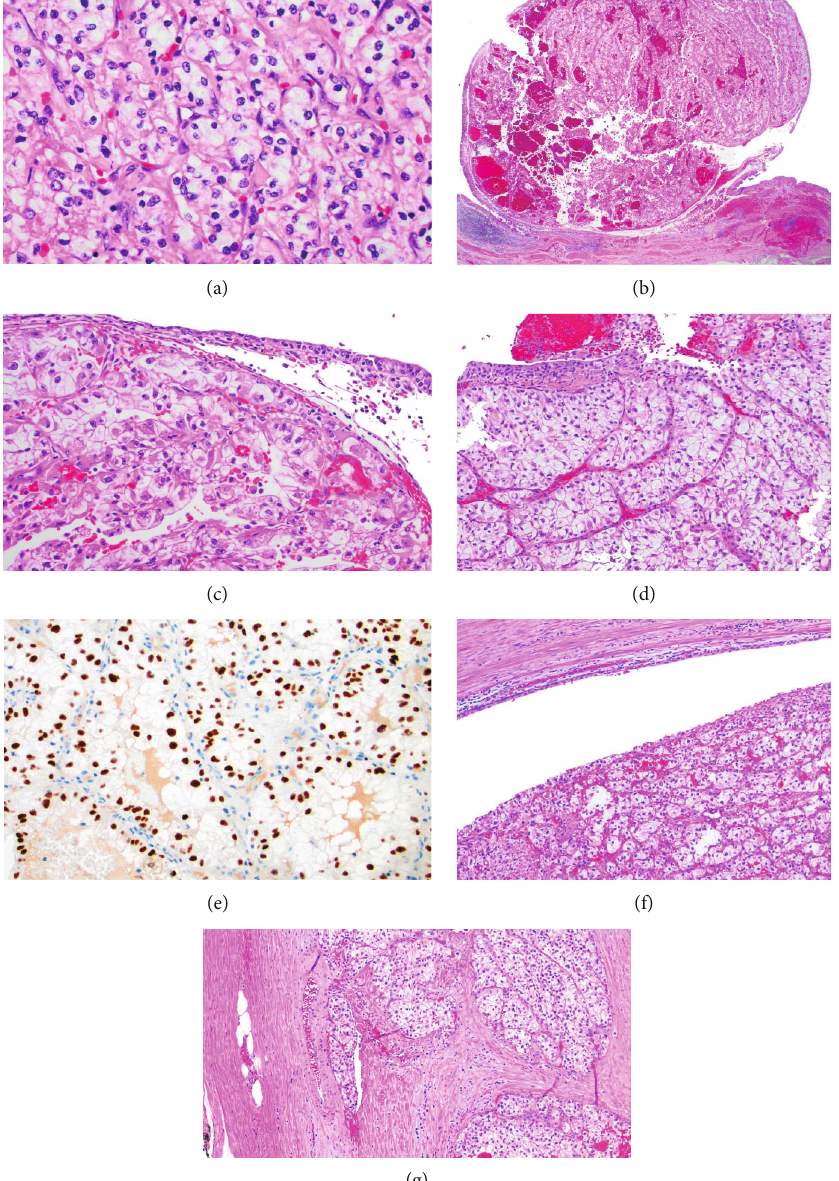
Figure 2: H&E-stained sections from the radical nephrectomy showed (a) areas of classic low-grade clear cell renal cell carcinoma (40x) and (b) an exophytic nodule of tumor undermining ureteral epithelium (2x). (c) Higher magni fi cation of tumor invading the ureteral wall shows higher grade nuclei and tumor cells with voluminous and focally eosinophilic cytoplasm undermining urothelium (20x). (d) Transurethral resection of the subsequent bladder tumor showed tumor morphologically identical to that seen in the nephrectomy depicted in panel (c), undermining benign urothelium. (e) PAX8 shows di ff use nuclear labeling consistent with renal cell carcinoma metastatic to the bladder (20x). (f) Subsequent ureteral resection showed clear cell renal cell carcinoma forming an intraluminal mass with benign urothelium above (10x). (g) Focal lymphovascular invasion was noted within the ureteral wall